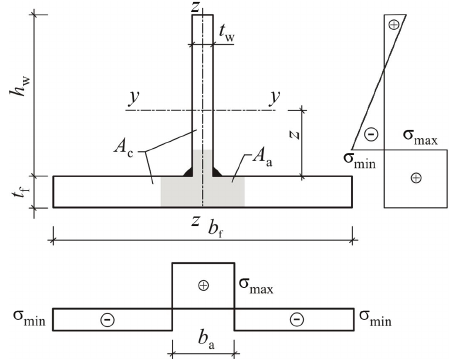
Fig. 5. Longitudinal welding stresses